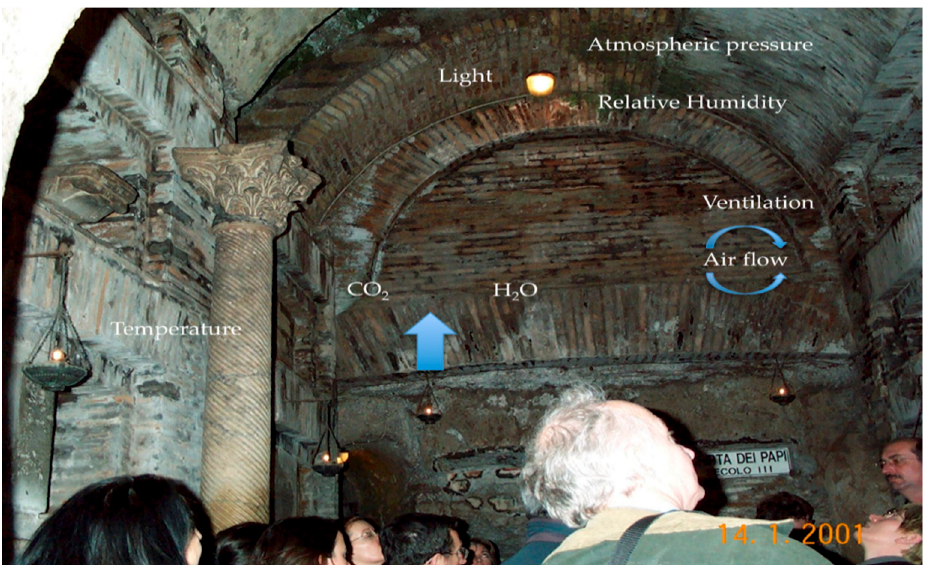
Figure 1. Example of physicochemical parameters affecting an indoor environment. The presence of visitors requires lights and produces an increase of temperature, relative humidity, and release of CO 2, dramatically changing the delicate equilibrium of these environments. The image shows the Crypt of Popes in St. Callistus Catacombs, Rome, Italy, during the CATS project (photo, C. Urzì).